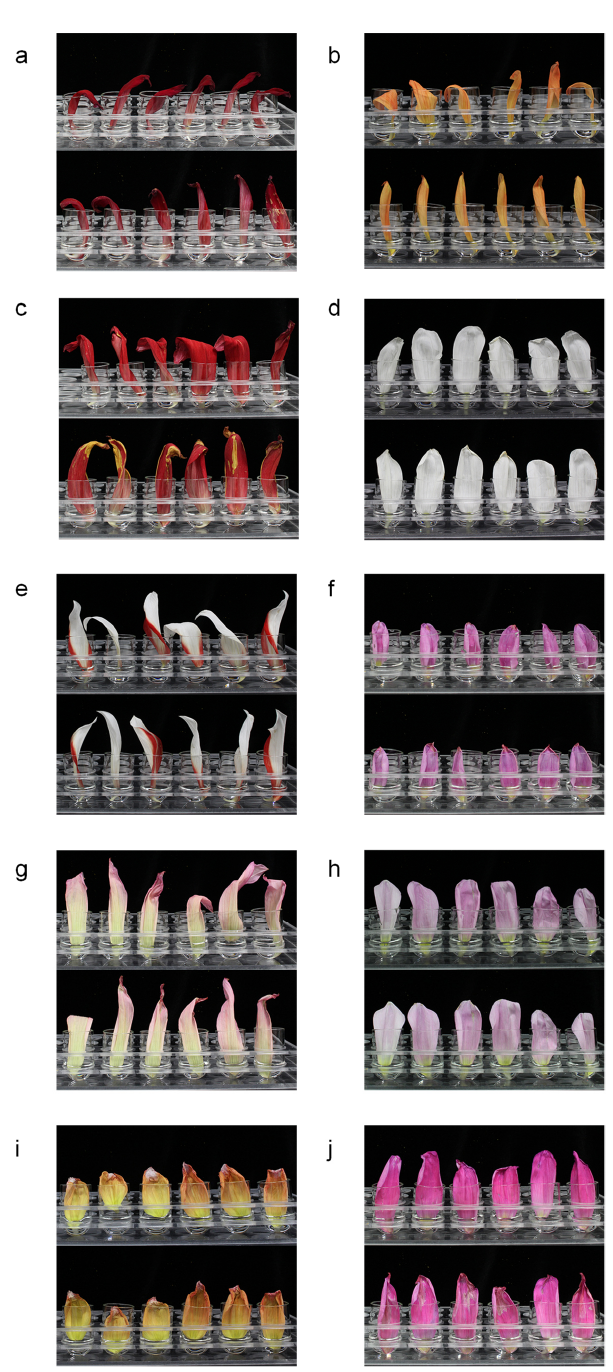
Figure 4. The effect of water supply on recovery from wilting in isolated petals of 10 cultivars. The upper panel shows petals on the day of wilting, and the lower panel shows petals 1 day after the start of water supply in each cultivar. ( a ) ‘Agitate’; ( b ) ‘Carnelian’; ( c ) ‘Garnet’; ( d ) ‘Kamakura’; ( e ) ‘LaLaLa’; ( f ) ‘Micchan’; ( g ) ‘Moon Waltz’; ( h ) ‘Namahage Cute’; ( i ) ‘Port Light Pair Beauty’; ( j ) ‘Rose Quartz’.